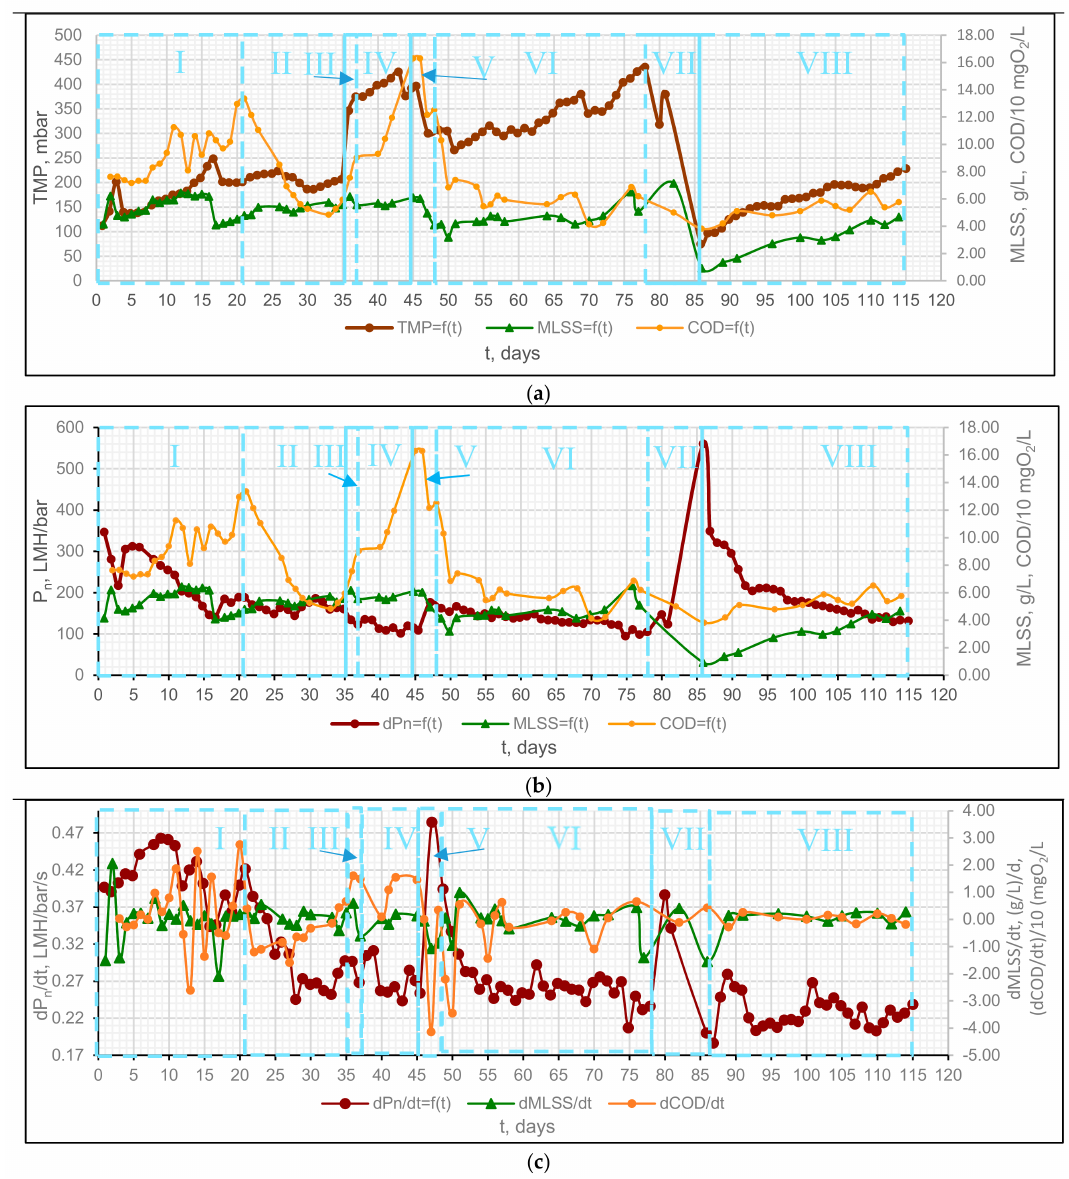
Figure 2. BF-MBR pilot plant operation profile: ( a ) TMP, MLSS-III, COD-III change within operation time; ( b ) normalized permeability (P n ), MLSS-III, COD-III change within operation time; ( c ) first derivative of normalized permeability (dP n /dt), MLSS-III (dMLSS/dt), COD-III (dCOD/dt) within operation